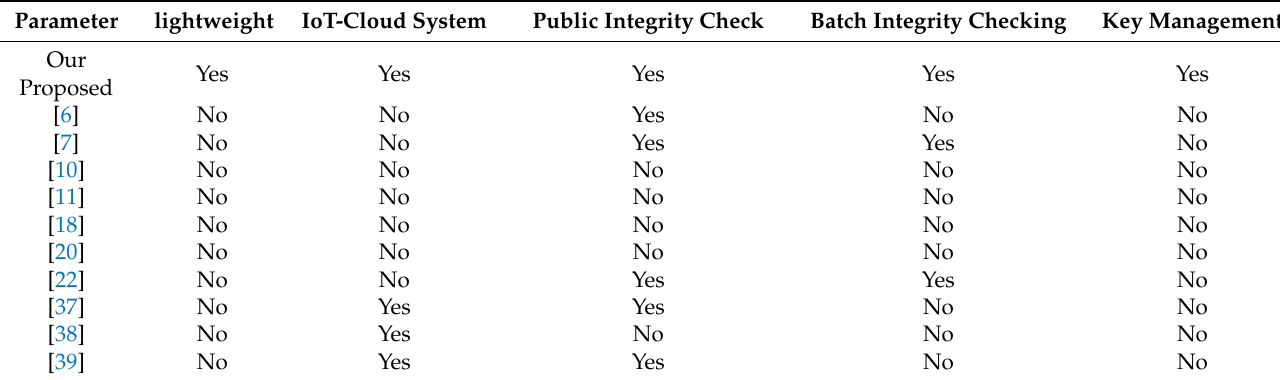
Table 1. Contrasts of information honesty